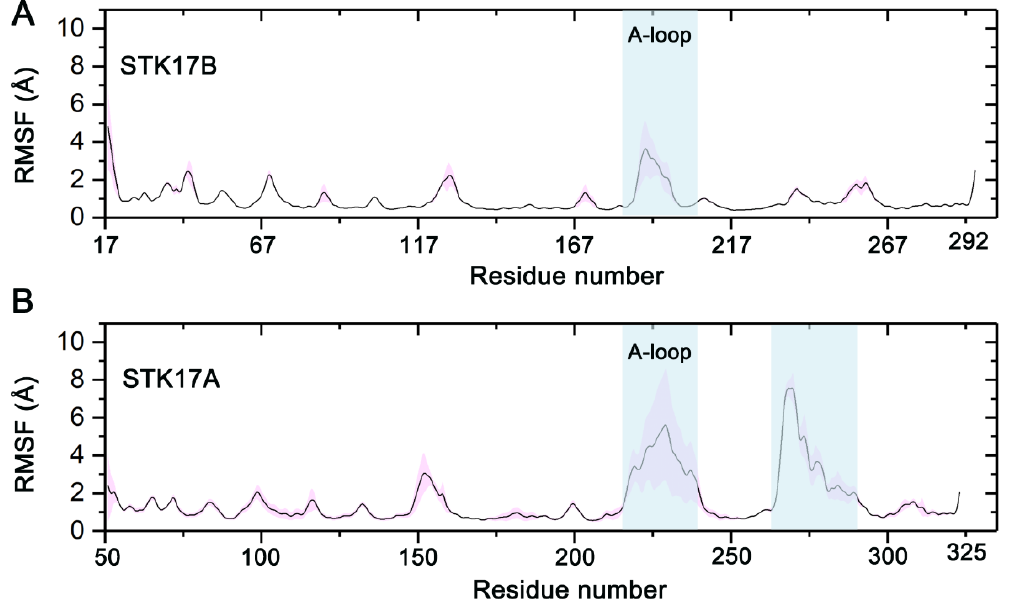
Figure 4. The C α atoms of root-mean-square fluctuation (RMSF) for STK17B ( A ) and STK17A ( B ) averaged over four independent runs. Transparent shade represents standard deviations.